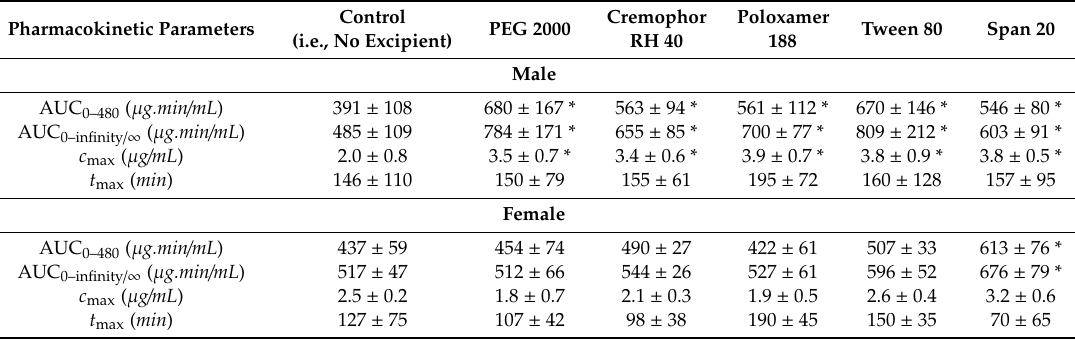
Table 2. Effect of excipients on the pharmacokinetic parameters of ranitidine in male and female Wistar rats (mean ± SD, n = 6). * Values are statistically different between the control and excipient groups at p < 0.05.